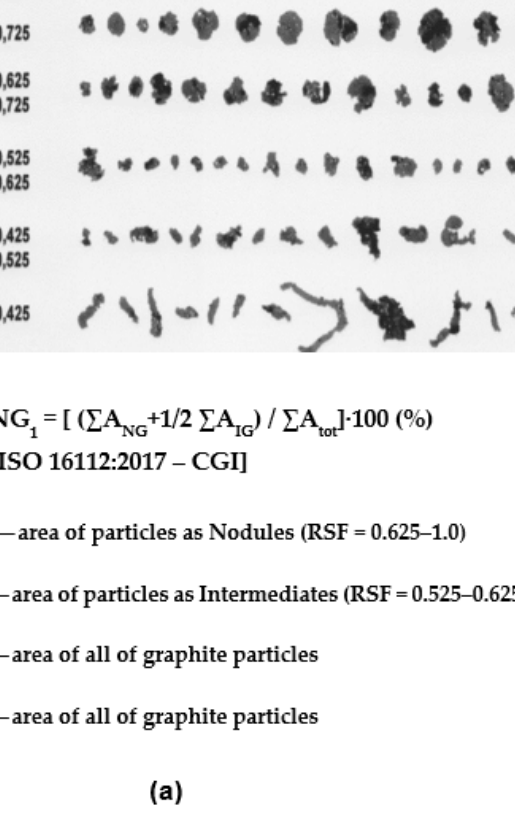
Figure 3. Calculus of the Graphite Nodularity (NG) depending on the Roundness Shape Factor (RSF) according to ISO 16112-2017-CGI ( a ) and ISO 945-4-2019-DI ( b ). According to ISO 16112:2017-CGI (Figure 3a), the standard considers all of the graphite particles defined as nodules (RSF > 0.625) and 50% of the graphite particles included in the intermediate class (RSF = 0.525–0.625). ISO 945-4-2019-DI considers all of the graphite particles defined by spheroidal graphite (RSF ≥ 0.80) and 90% of the slightly irregular graphite particles (RSF = 0.60–0.80). A comparison of the respective graphite